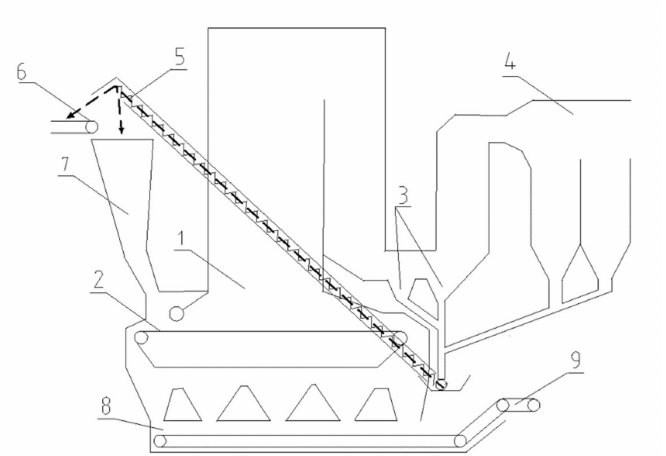
Figure 3. The principle of fly ash recirculation in a stoker furnace to reduce ammonia slip in fly ash. 1-combustion chamber, 2-grate, 3-ash hoppers, 4-de-dusting system, 5-pneumatic conveyor, 6-fuel feeder, 7-fuel tank, 8-slag hopper, 9-slag removing